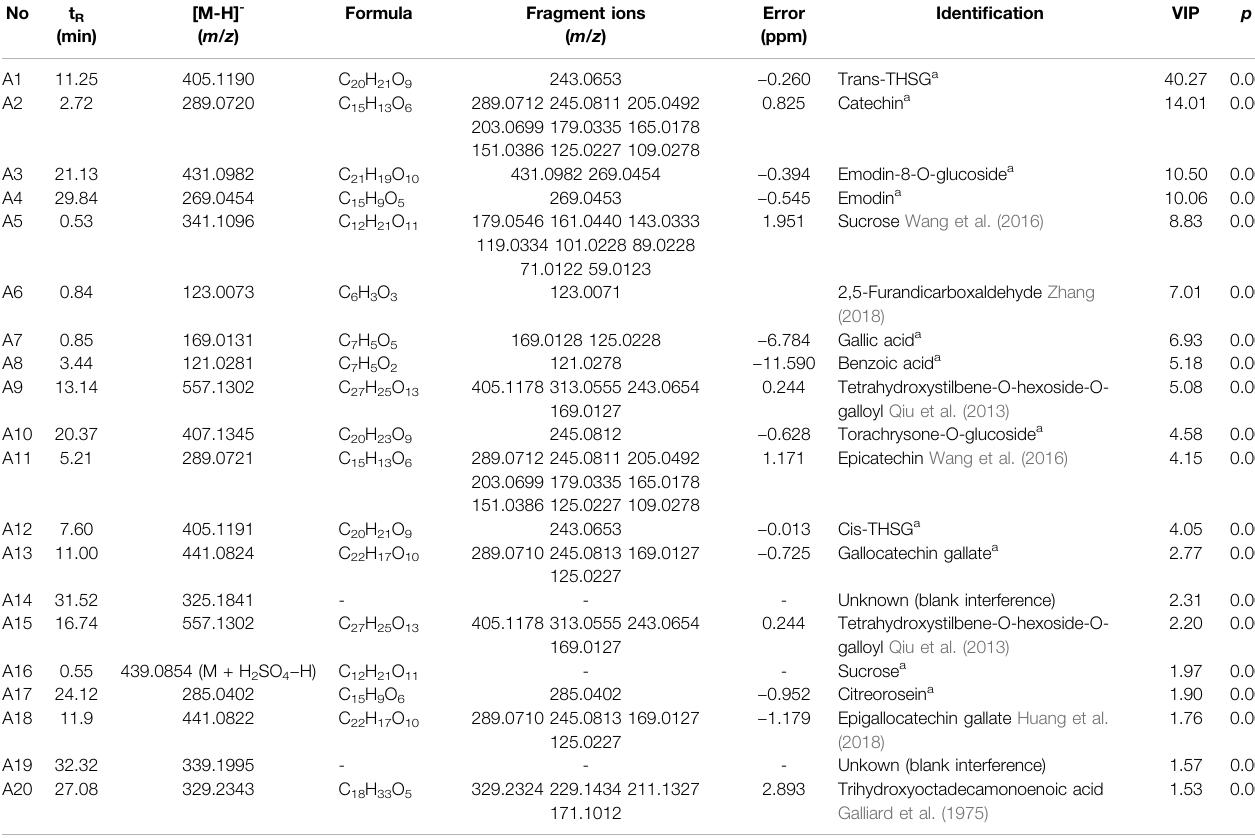
a Compared with standard compounds.